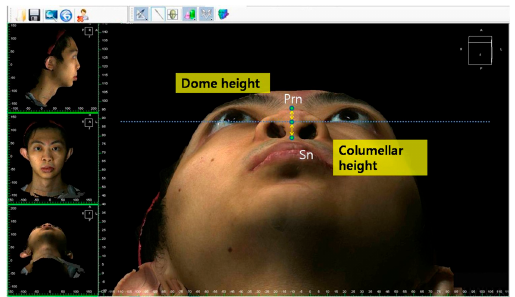
Figure 5. Representation of tip angle.